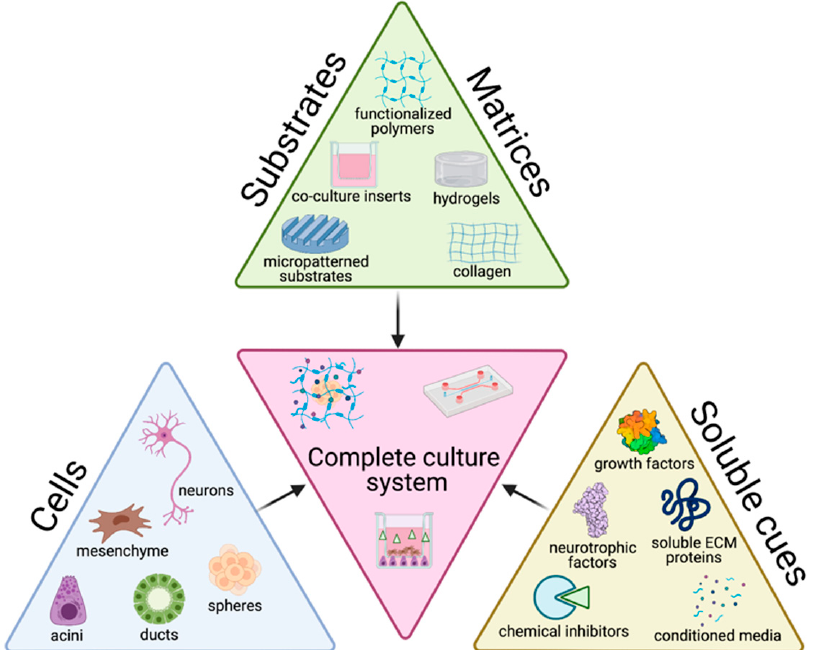
Figure 2. Schematic of the tissue engineering triad as it relates to salivary gland cell culture strategies with examples of a complete culture system.